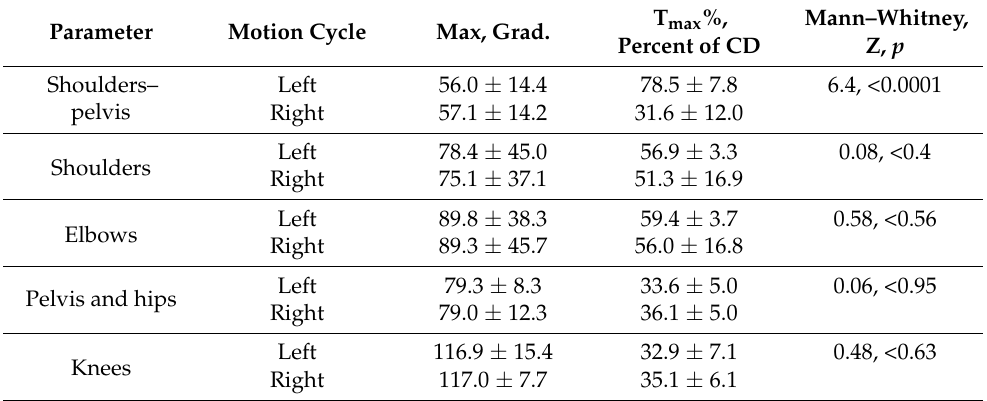
Table 2. Amplitude-phase characteristics of motions for the left and right side. Means and standard deviations are presented. Comparison was executed by Mann–Whitney nonparametric